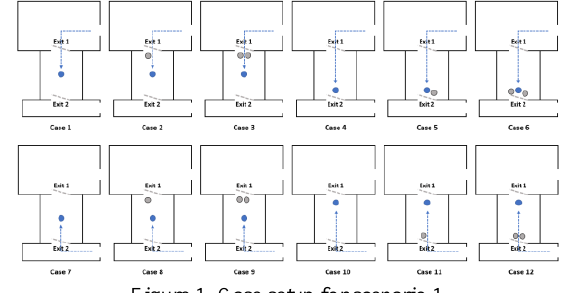
Figure 1. Case setup for scenario 1